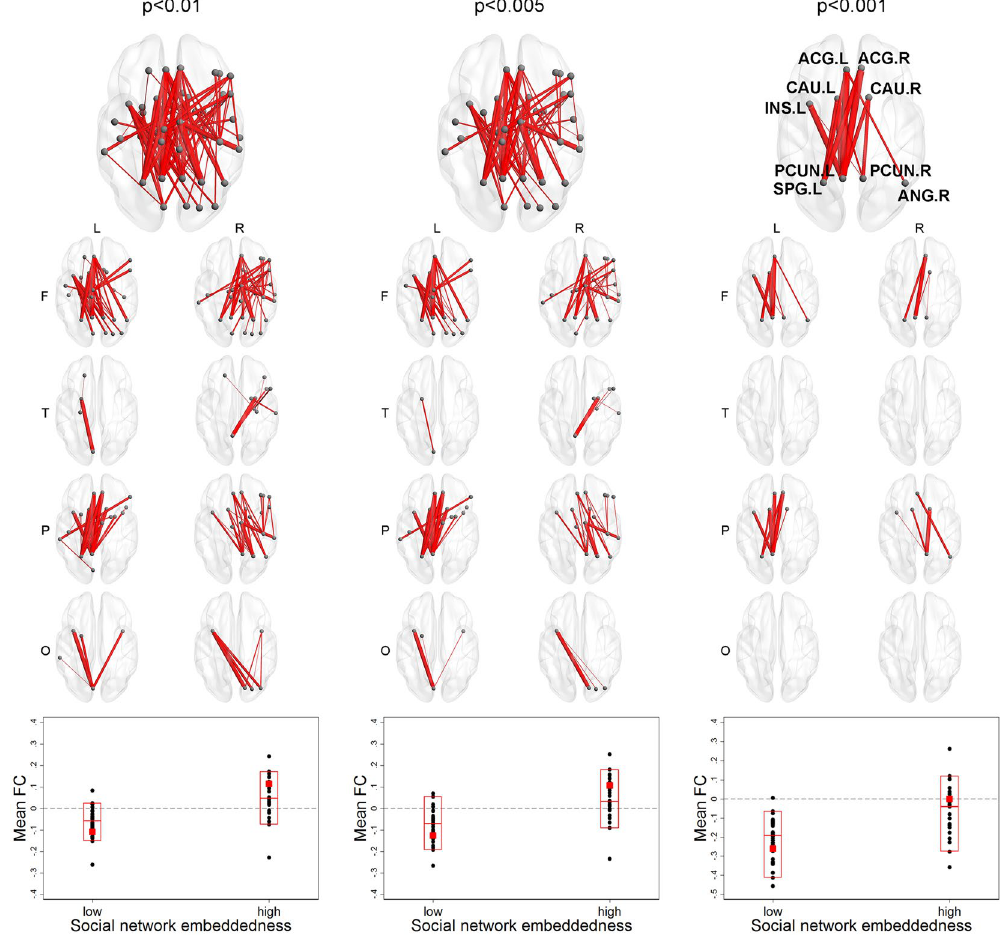
Figure 6. Component-level associations between functional connectivity and social network embeddedness (low = 0, high = 1). A brain figure for the whole component and eight separate figures for the regional connectivity from left/right frontal/temporal/parietal/occipital lobes are presented for each threshold. The largest component positively associated with social network embeddedness at the thresholds of p < 0.01, p < 0.005, or p < 0.001 had significantly larger extent and intensity than simulated networks. Mean functional connectivity among the ROIs in each component was higher for those with high social network embeddedness than low social network